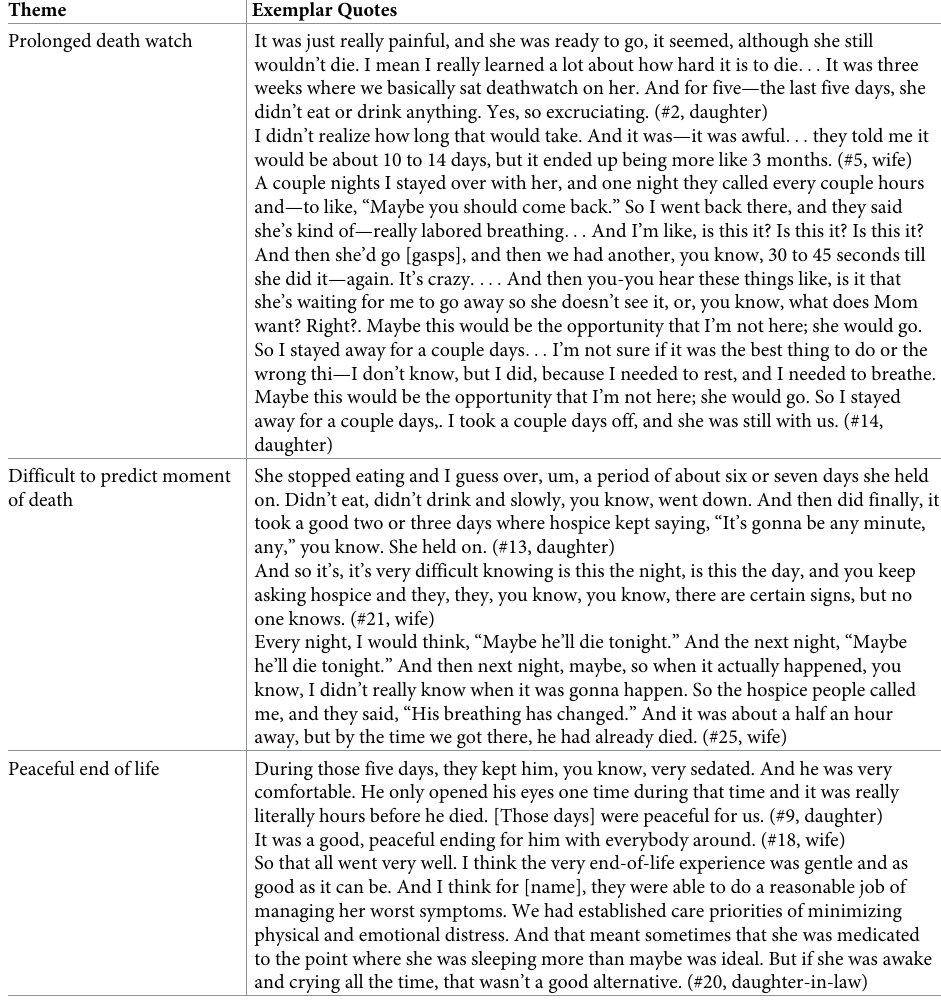
Table 2. Experiences in the final days to weeks of